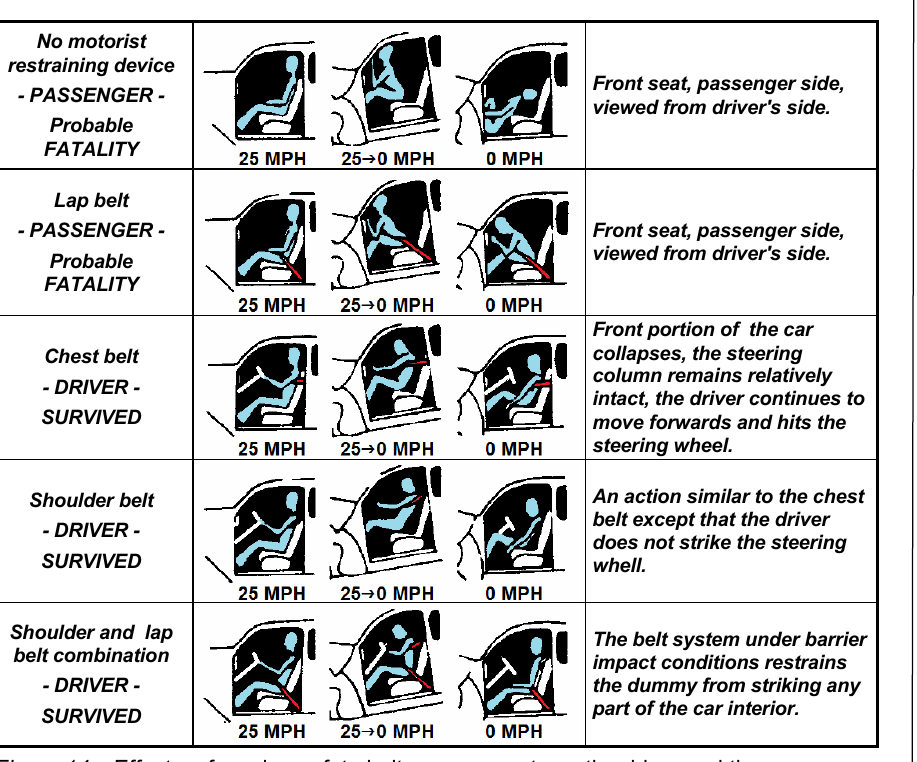
Figure 14 – Effects of varying safety-belt arrangements on the driver and the passenger in a 25-mph automobile collision with a fixed barrier (40